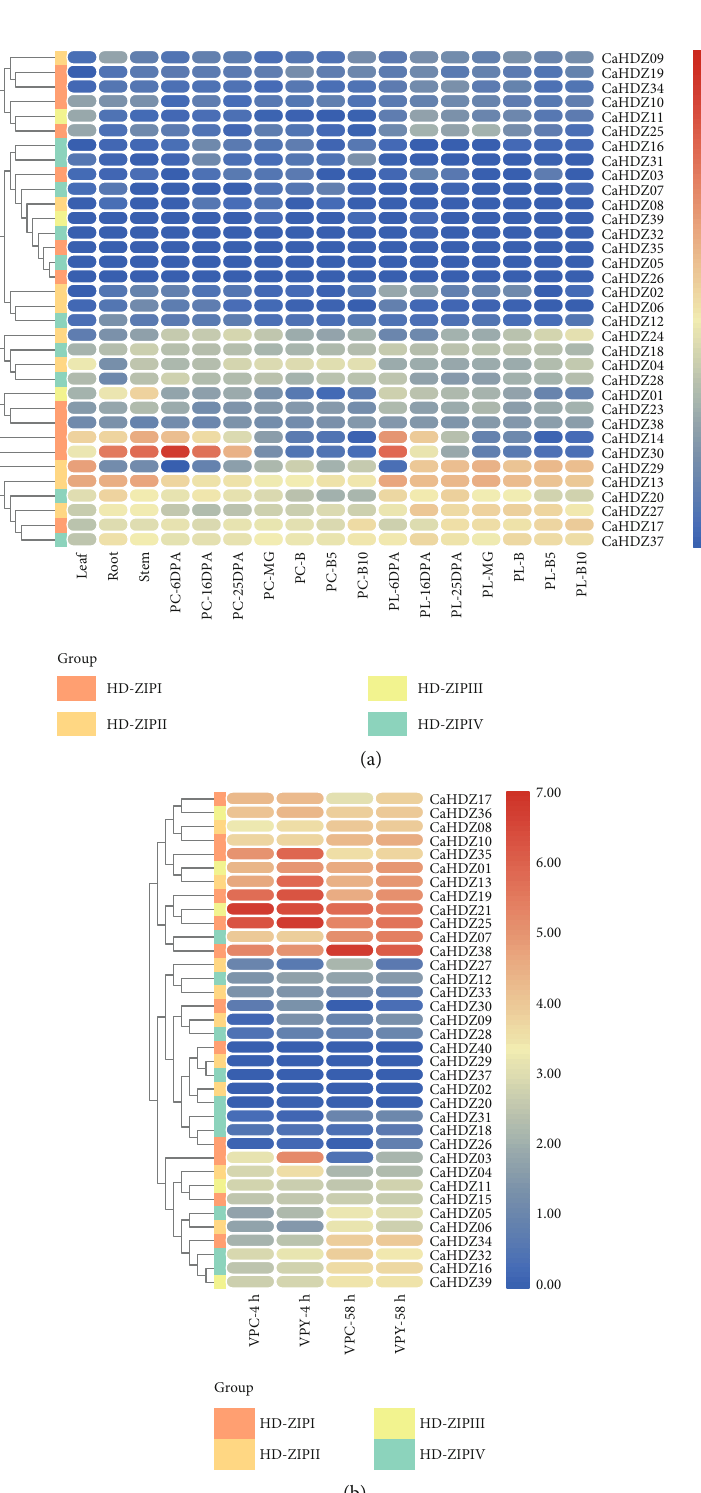
Figure 5: (a) Pepper HD-ZIPgenes expression of di ff erent tissues and developmental stages. Raw data were taken from RNA-seq data of CM334. The tissues included root, stem, leaf, pericarp (PC), and placenta (PL) at 6, 16, and 25 days postanthesis (DPA), PC and PL at mature green (MG) and at breaker (B) stages, PC and PL at 5 (B5) and 10 (B10) days after postbreaker, respectively. (b) The heat map of CaHD-ZIP genes under NaCl treatment (VPC represents CK, VPY represents NaCl stress). Blue and red colors represent relatively low and high expression (log 2 RPKM